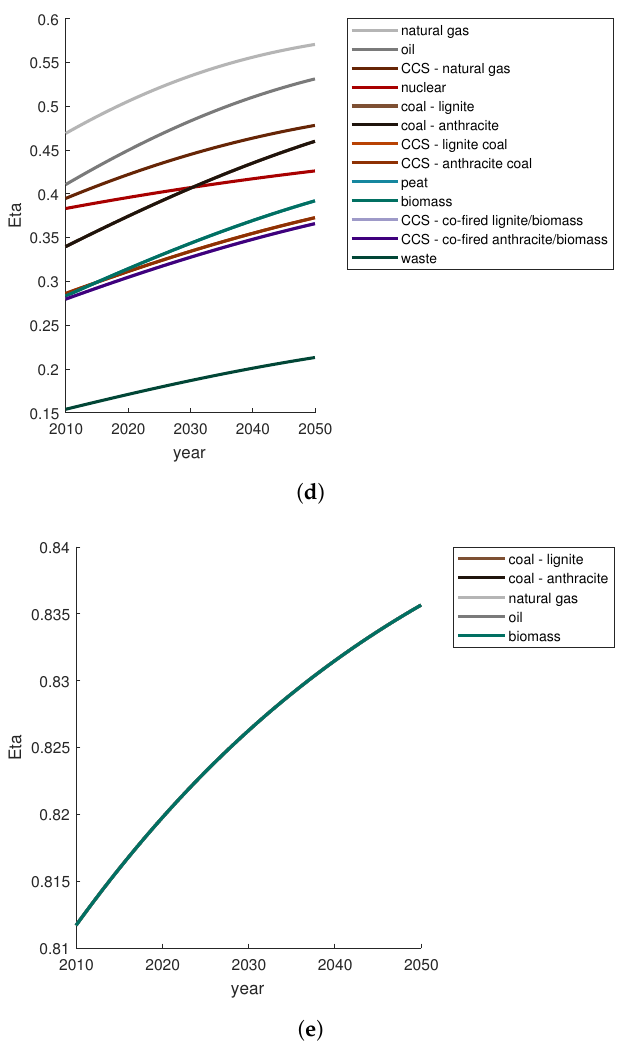
Figure A1. Technology assumptions include: ( a ) The investment costs for all solar and wind electricity generation technologies (upper) and storage technologies (lower) in the base scenario. ( b ) The operation and maintenance costs for all solar and wind electricity generation technologies in the base scenario. ( c ) The expected improvements in cycle efficiency (eta) over time for the condensing power plant technologies in all scenarios. Note that in this subfigure the curves for natural gas and oil technologies are indistinguishable, as are the curves for peat and biomass technologies and CCS technologies with lignite and anthracite, respectively. ( d ) The expected improvements in cycle efficiency (eta) over time for the CHP power plant technologies in all scenarios. Note that in this subfigure that the curves for anthracite and lignite coal technologies are indistinguishable, as are the curves for peat and biomass technologies, respectively. ( e ) The expected improvements in cycle efficiency (eta) over time for the back-pressure power plant technologies in all scenarios. Note in this subfigure that the curves for conventional coal, natural gas, oil and biomass technologies are indistinguishable. Note furthermore that back pressure plants are disallowed for all other